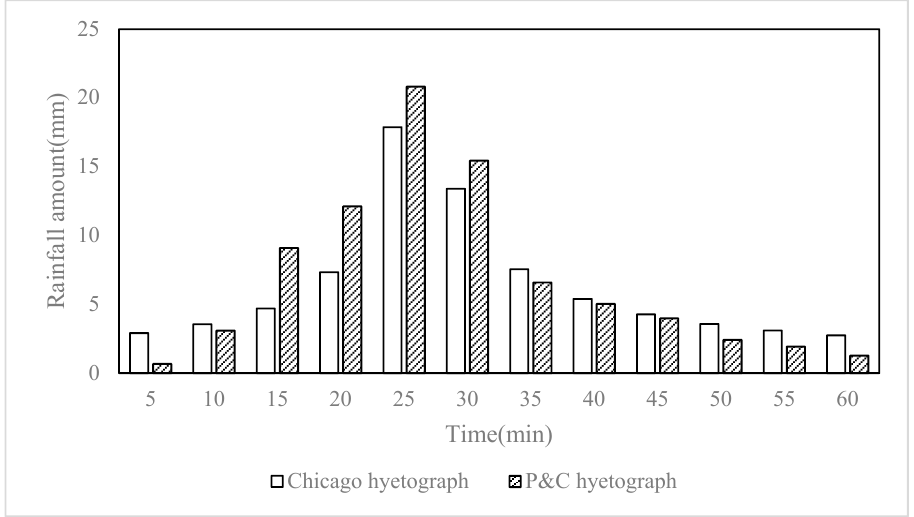
Figure 7. The 60-min design hyetograph with a 20-year return period using Chicago rainstorm method and P&C method (single-peak). The blue bar denotes the Chicago hyetograph and the orange bar denotes the P&C hyetograph.